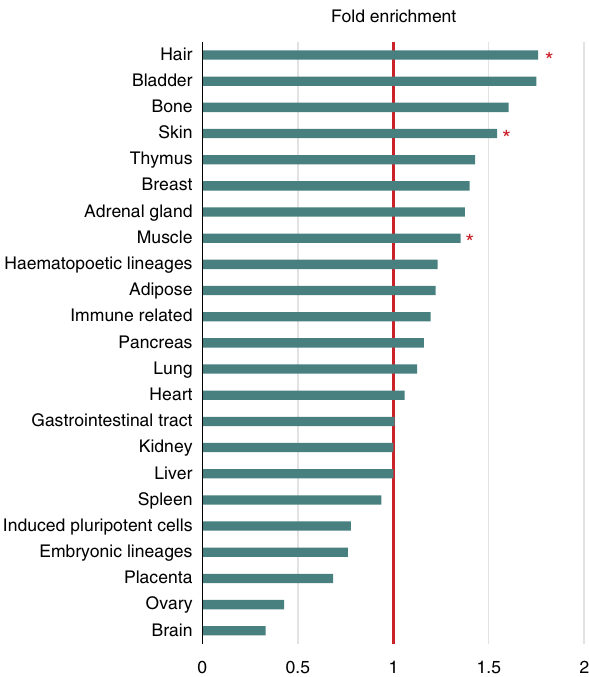
Figure 2 | Enrichment of credible SNPs in tissue enhancers. Barplot showing enrichment of MPB credible SNPs across 23 tissue specific enhancer sets. A total of 144 cell lineages and tissues were grouped in 23 categories for this evaluation. The expected number of credible SNPs and the significance of enrichment in each category were estimated in one million enhancer matched permutations, using the rest of the tissue types to define the candidate null set (Supplementary Data 2). Red asterisks indicate tissue types that contain individual cell lineages or tissues that show an enrichment of credible SNPs with an empirical P -value of o 0.05: non-balding DPCs treated with DHT (hair); one of three foreskin fibroblasts (skin); and one of three psoas muscle